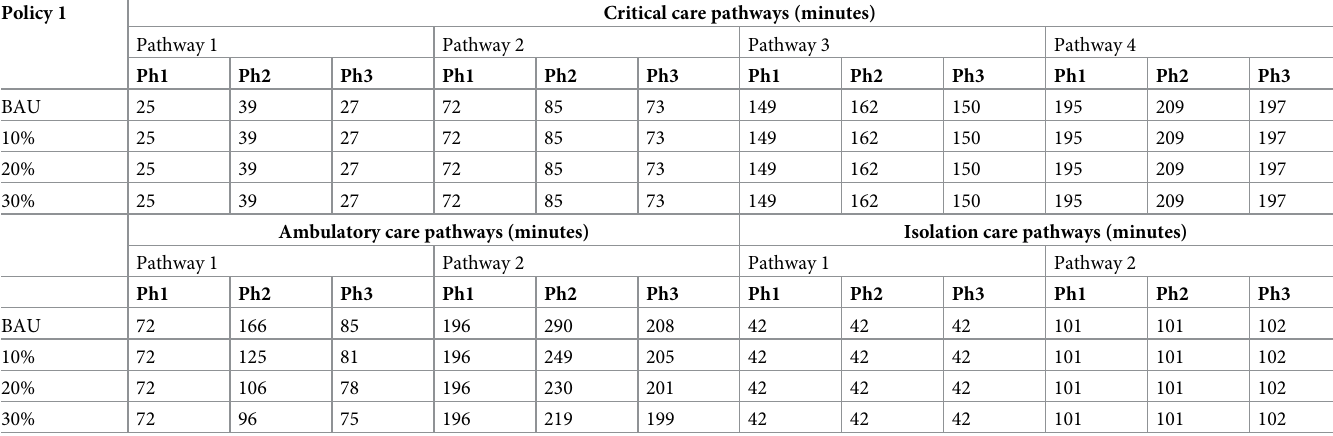
Table 1. ALOS ED patients face depending on care venue, patient pathway, arrival time for co-location policy where 10% - 30% of P4 and P3 patients are decanted from the ED to a GP clinic co-located in the ED. Policy 1 Critical care pathways (minutes) Pathway